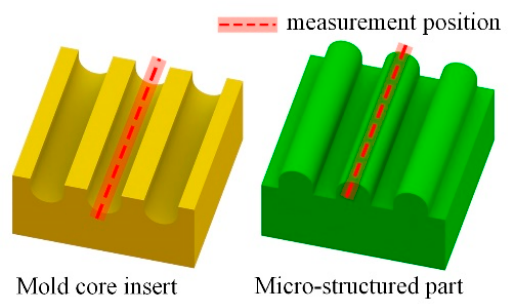
Figure 4. The measurement of roughness (Ra) on the bottom of the micro-groove of the mold core insert and the top of the corresponding micro-structured part.